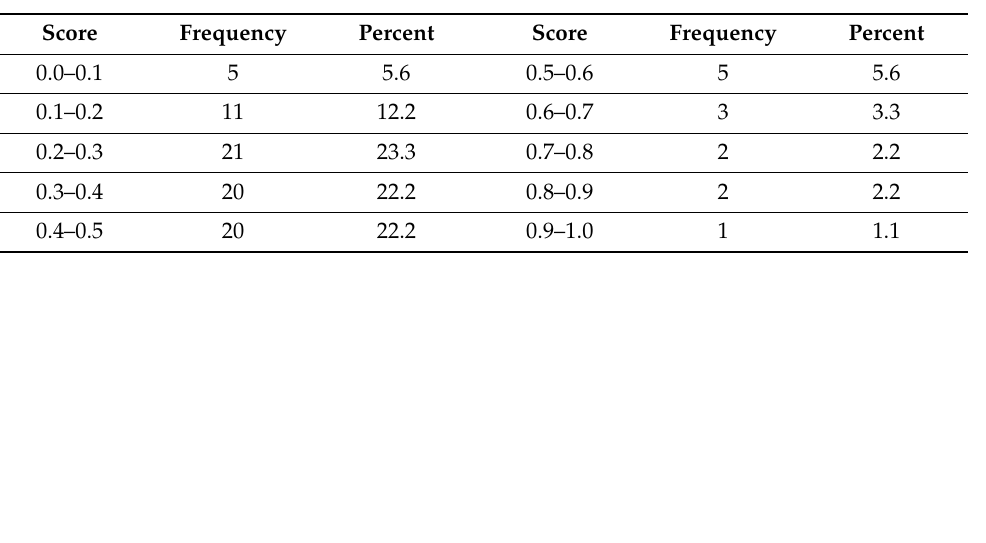
Figure 6. Box and whisker plot of VRS efficiency by groups.